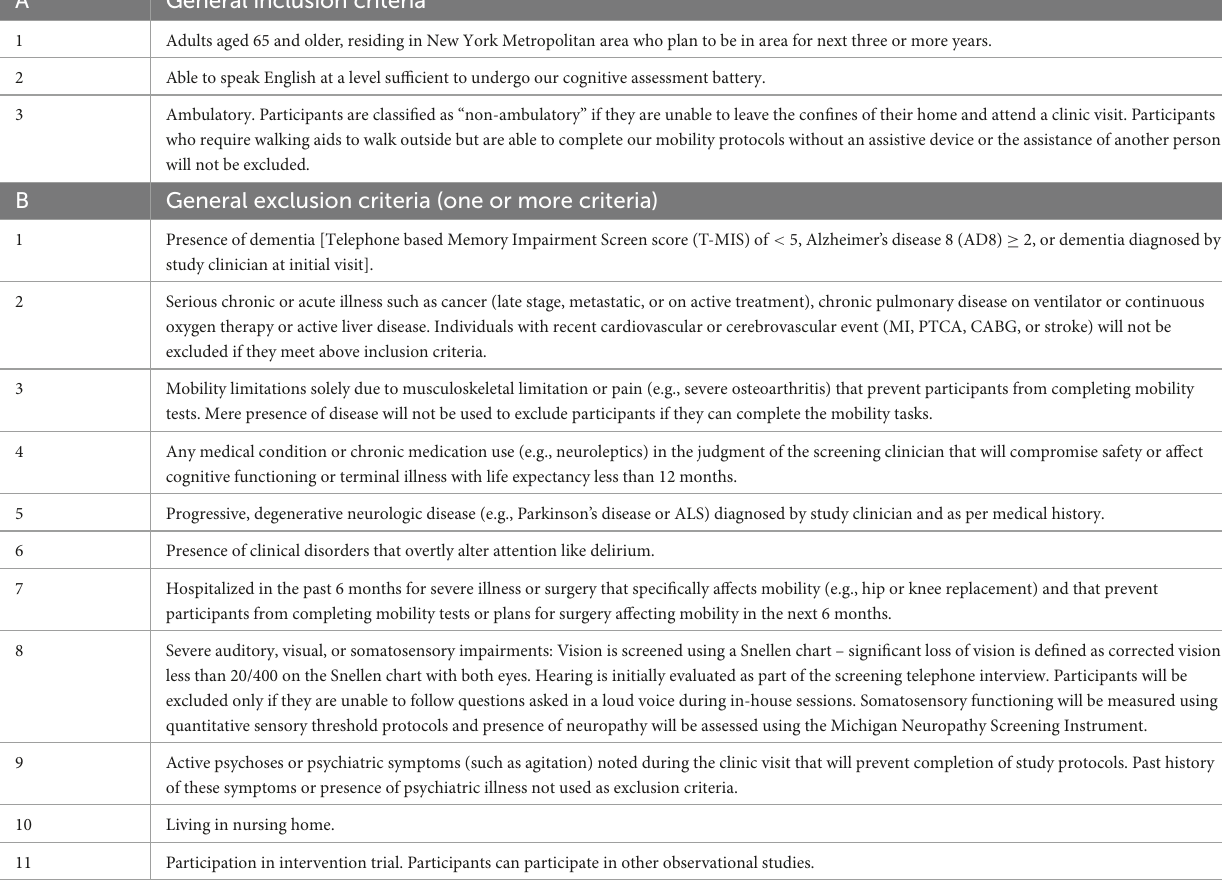
TABLE 1 VSI Study eligibility